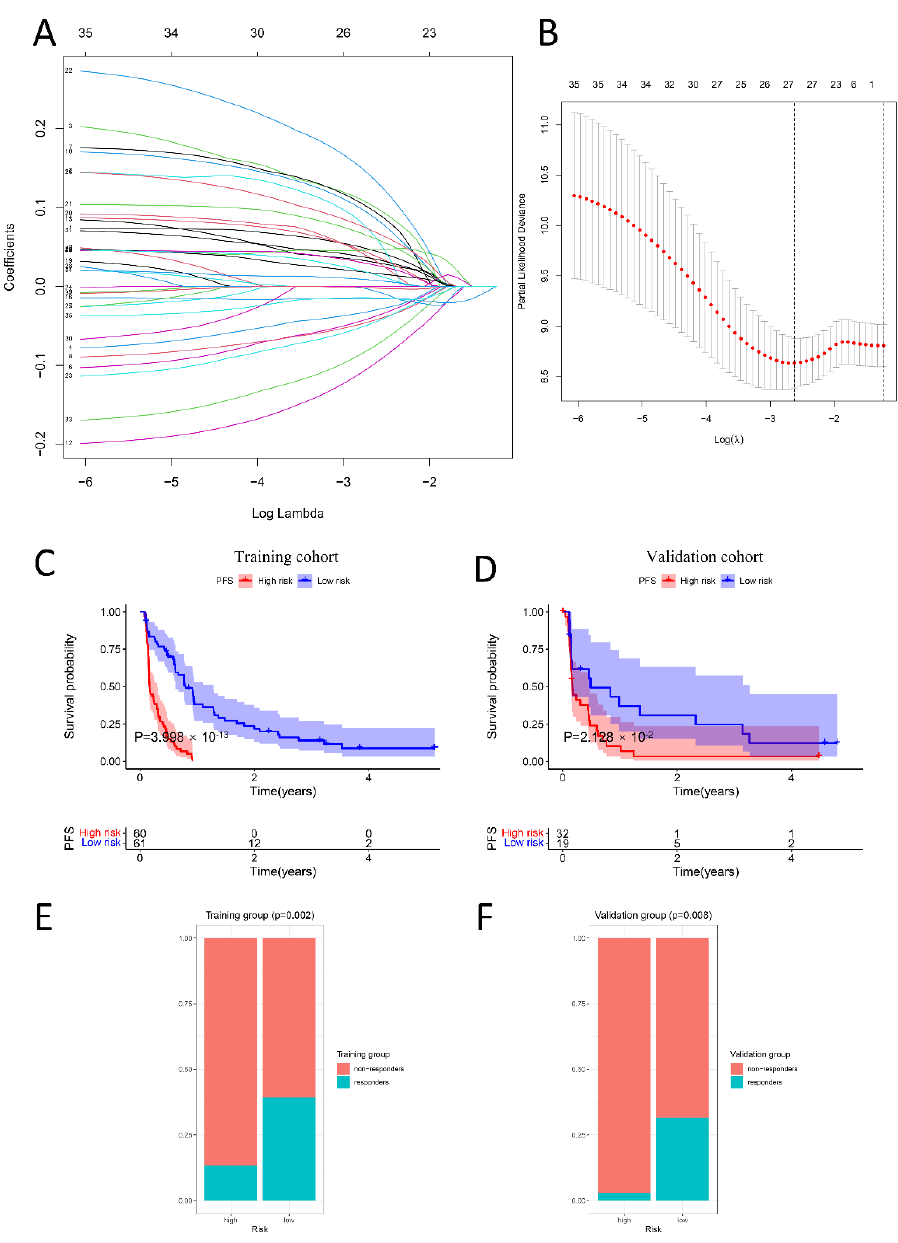
Figure 6. Construction and validation of the prognosis model for PFS in the CheckMate cohort ( n = 172). ( A , B ): A total of 27 genes correlated with PFS were selected via LASSO regression analysis and ten-fold cross-validations for screening of the optimal parameter lambda. ( C , D ): The samples were randomly classified into training and validation cohorts at a 7:3 ratio with the createDataPartition algorithm. Kaplan-Meier survival plots suggested that the low-risk group exhibited better PFS than the high-risk group in the training cohort and validation cohort. Blue indicates the survival curve of the low-risk group, and red indicates the survival curve of the high-risk group ( E , F ): There existed obvious differences in the proportion of responders and non-responders between the high-risk group and low-risk group both in the training cohort and validation cohort. The proportion of responders in the low-risk group is higher. The ratio of orange to green means the ratio of responders to